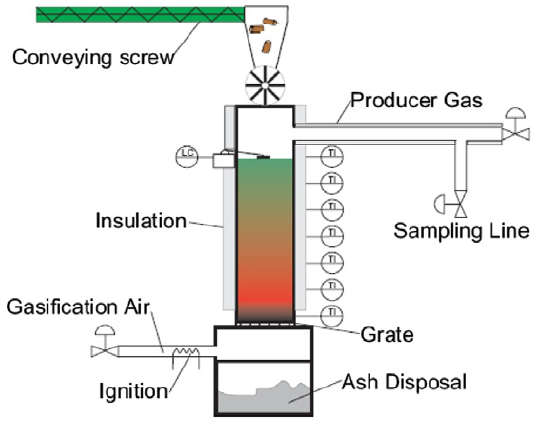
Figure 2. Sketch of the moving-bed counter-current gasifier